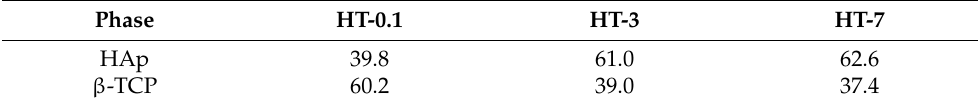
Table 1. Relative phase content (%) in biphasic CaP synthesized for varying